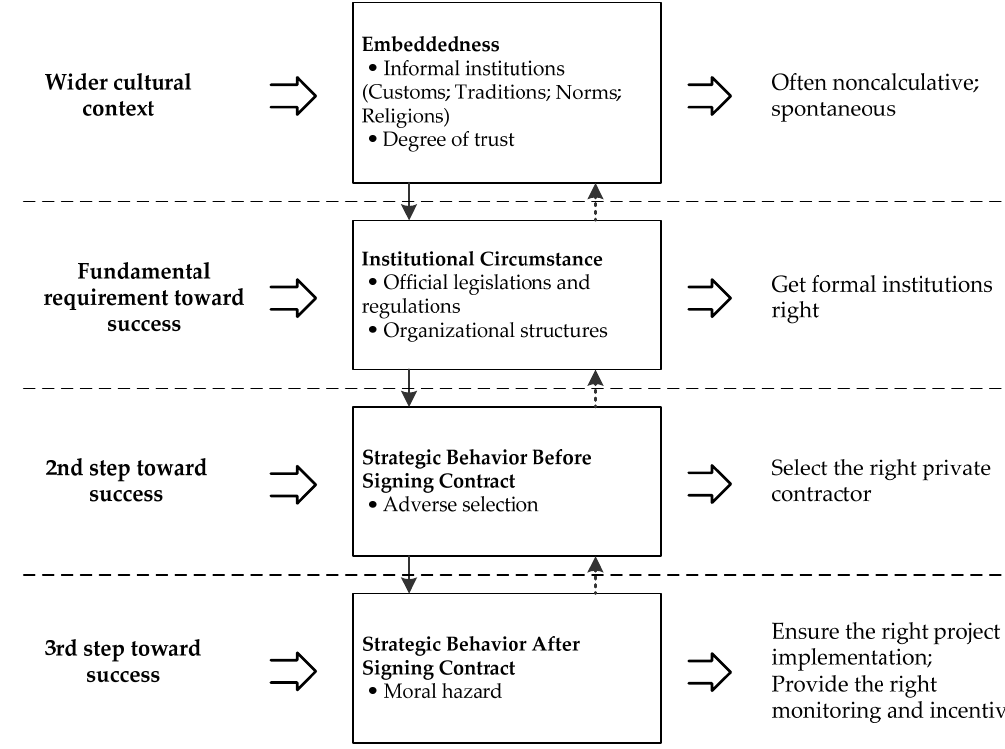
Figure 2. Multi-layered model of the PPP contracting